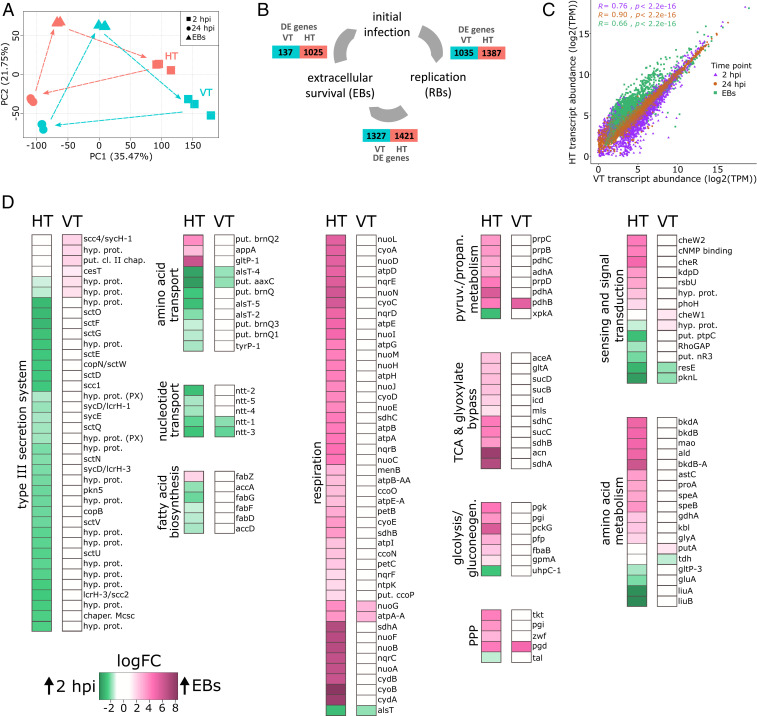
Genes involved in extracellular survival and virulence were up-regulated in HT symbionts. (A) Principal component (PC) analysis plot for RNA-Seq gene expression data at three time points of symbionts from the HT or VT treatment that were collected from amoeba host cells (2 hpi and 24 hpi) or from the medium (released EBs) (n = 3). (B) An overview of the total number of differentially expressed (DE) genes for either treatment between two consecutive time points that marked crucial developmental events during infection (n = 3). Genes were considered DE if their expression changed twofold with a FDR smaller than or equal to 0.05. (C) Scatterplot showing the correlation between transcript abundance in the two treatments at each time point (n = 3). Each dot on the scatterplot represents a single gene. Kendall’s tau coefficient at each time point is shown on the plot. (D) Heat maps depict those metabolic pathways and T3SS loci with marked differences between the HT and VT treatments with respect to logFC of genes that were differentially expressed between released EBs and the 2 hpi (FDR of 0.05) (n = 3). A logFC below 1 (no differential expression) is shown in white, significant up-regulation in released EBs is shown in pink, and significant up-regulation at 2 hpi is shown in green. The stronger the color, the stronger the gene expression change between the two time points. All logFC values are provided in Dataset S8.